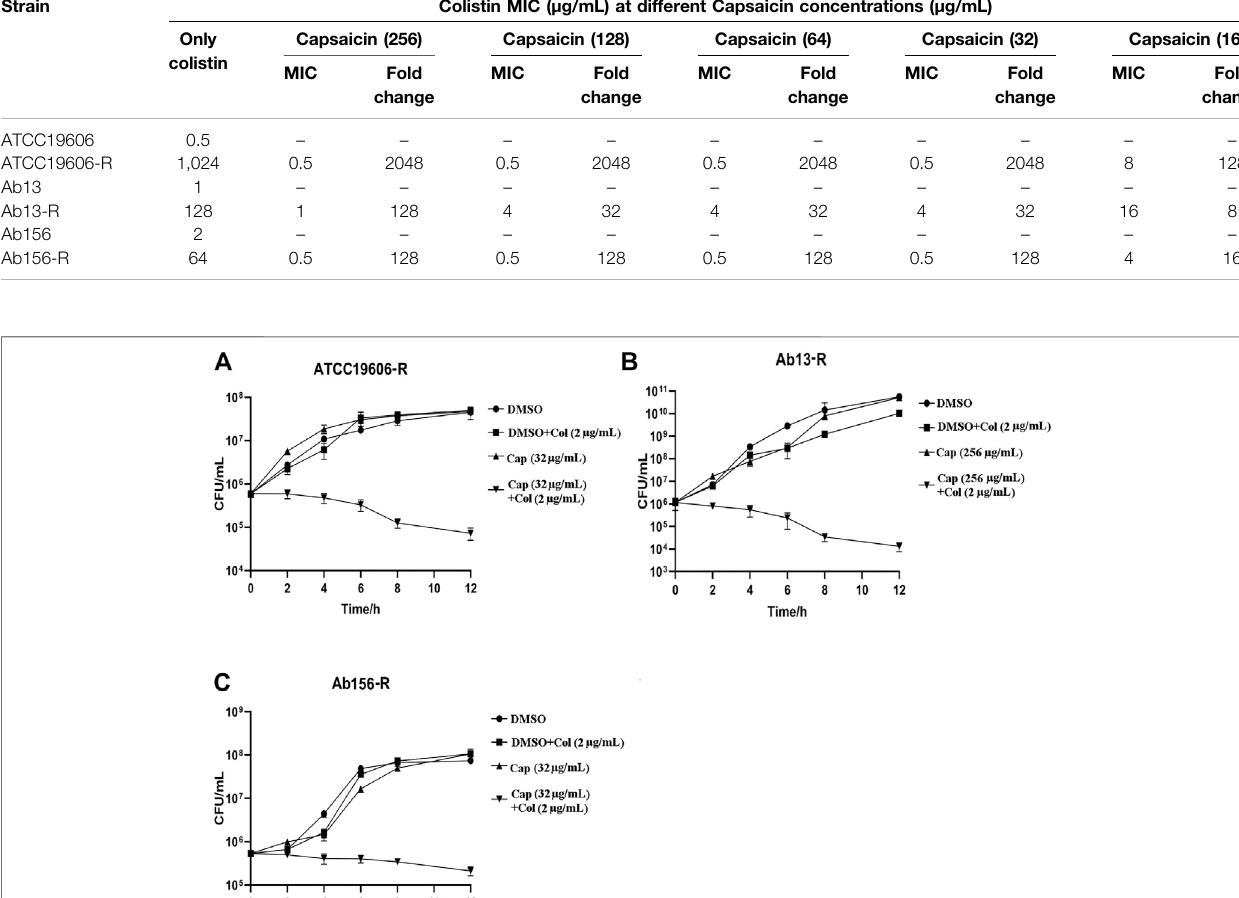
Frontiers in Pharmacology |